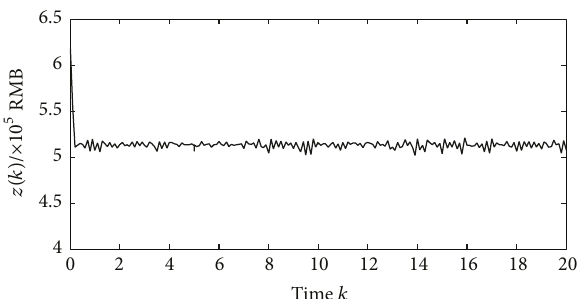
Figure 8: Evolution process of total cost under the fuzzy robust 𝐻 ∞ control